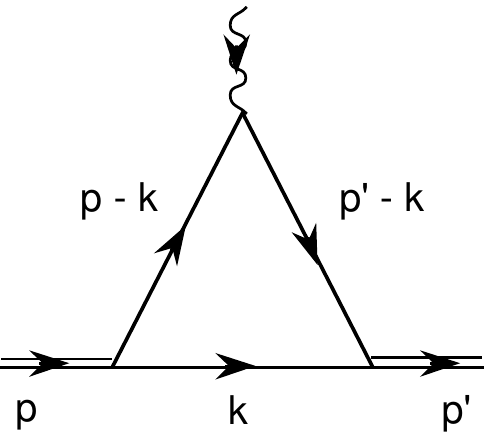
Figure 9. Feynman diagram for the electromagnetic form